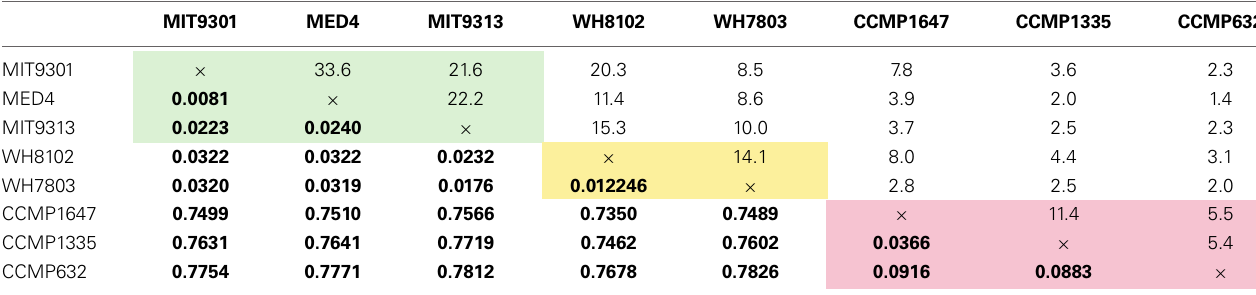
Table 4 | The percent of features shared among all pairwise strain comparisons (top) alongside sequence distances based on small subunit rRNA gene sequences (bottom in bold) for the eight phytoplankton strains tested in this